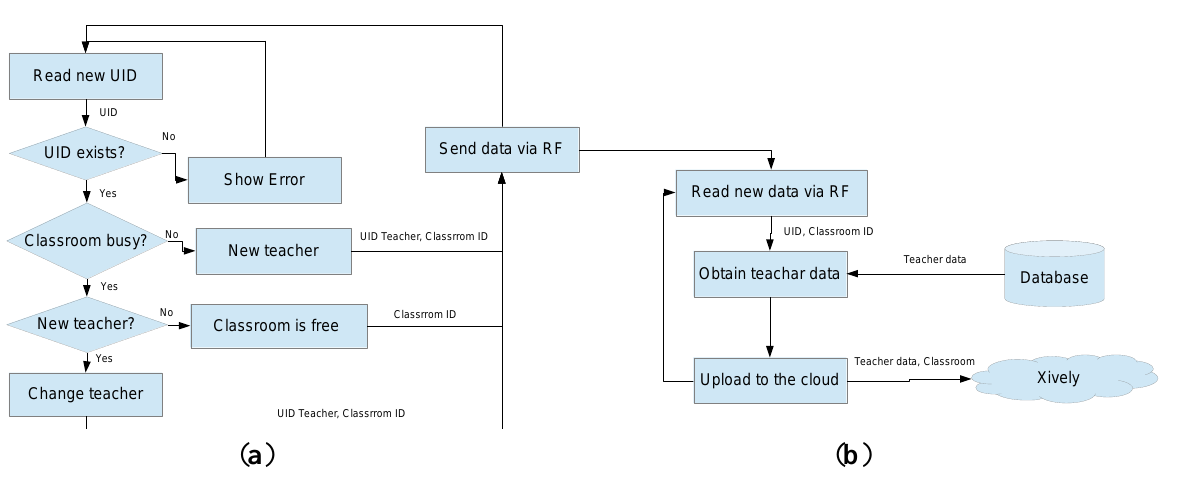
Figure 6. System flowchart diagram ( a ) reading cards ( b ) uploading data to